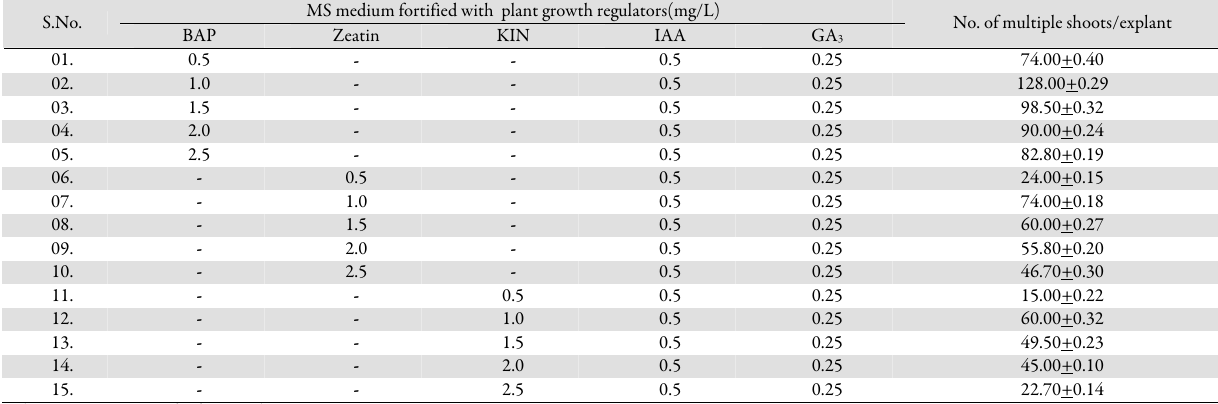
Table 2. Effect of PGR’s on proliferation of shoot buds of Physalis angulata L. at two weeks of culture MS medium fortified with plant growth regulators(mg/L) S.No.